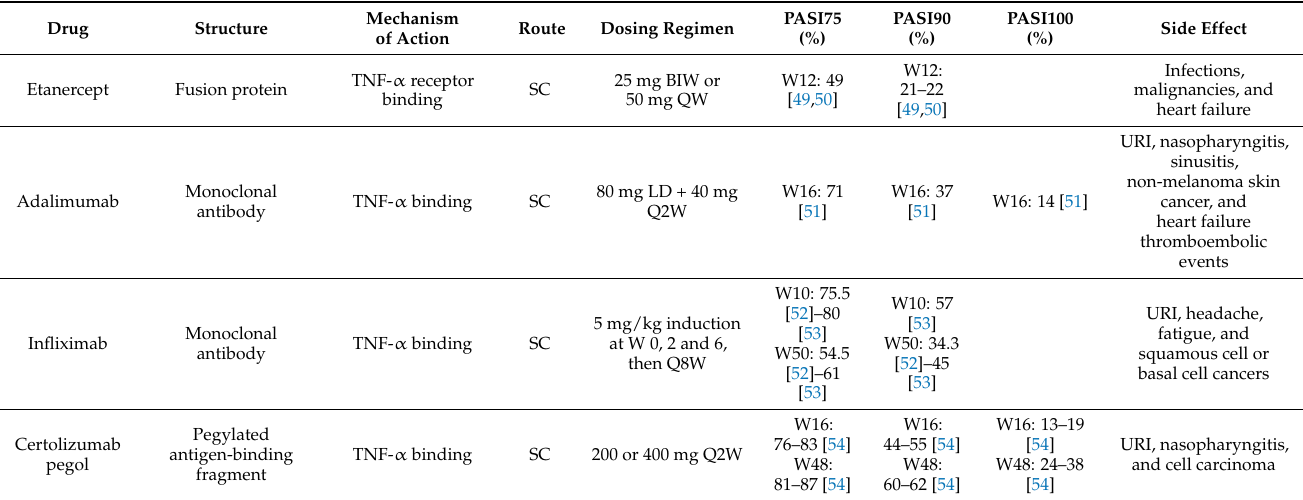
Table 1. List of biologics approved for